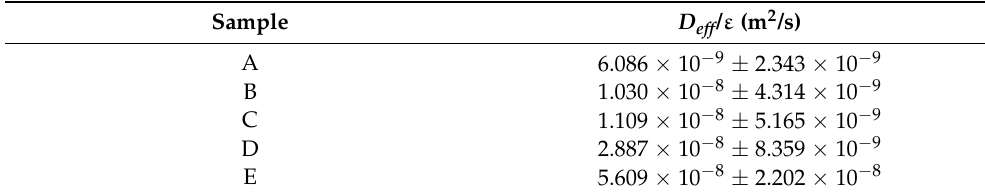
Table 3. Effective diffusion coefficients of the sol per porosity of each type of brick (95 per cent confidence interval).